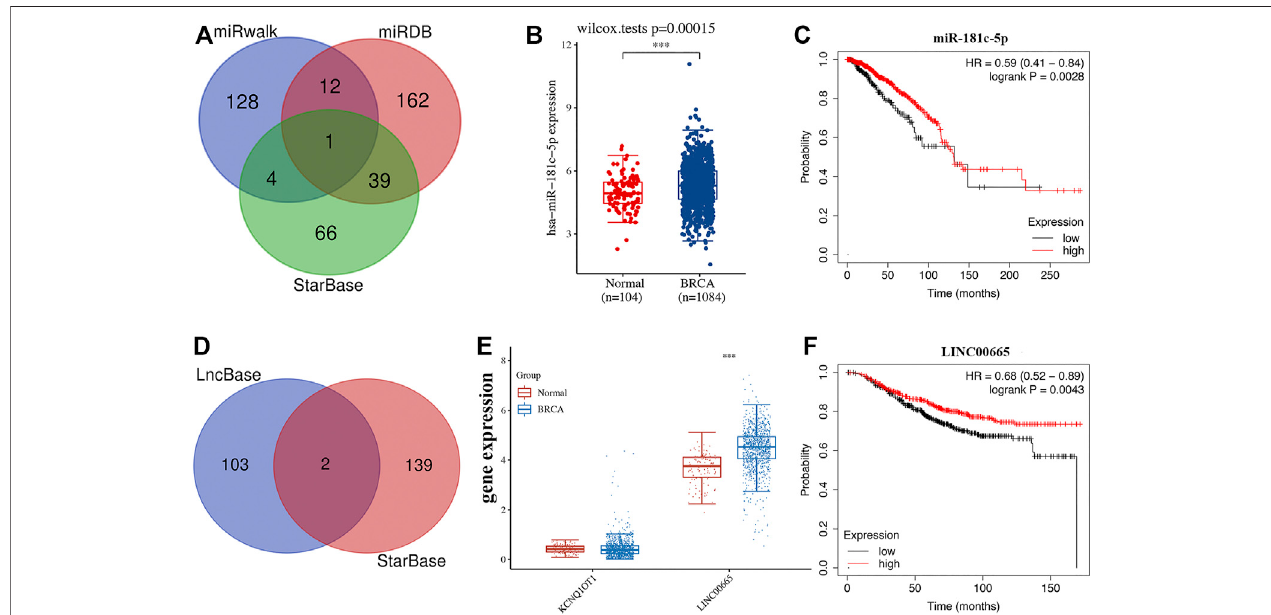
FIGURE 7 | Construction of lncRNA-miRNA-mRNA regulatory axis. (A) The miRNA targets predicted by miRDB, miRWalk, and StarBase. (B – C) The expression and prognosis value of miR-181c-5p in BRCA. (D) The lncRNA targets predicted by lncbase and StarBase. (E – F) The expression and prognosis value of lncRNA LINC00665 in BRCA.